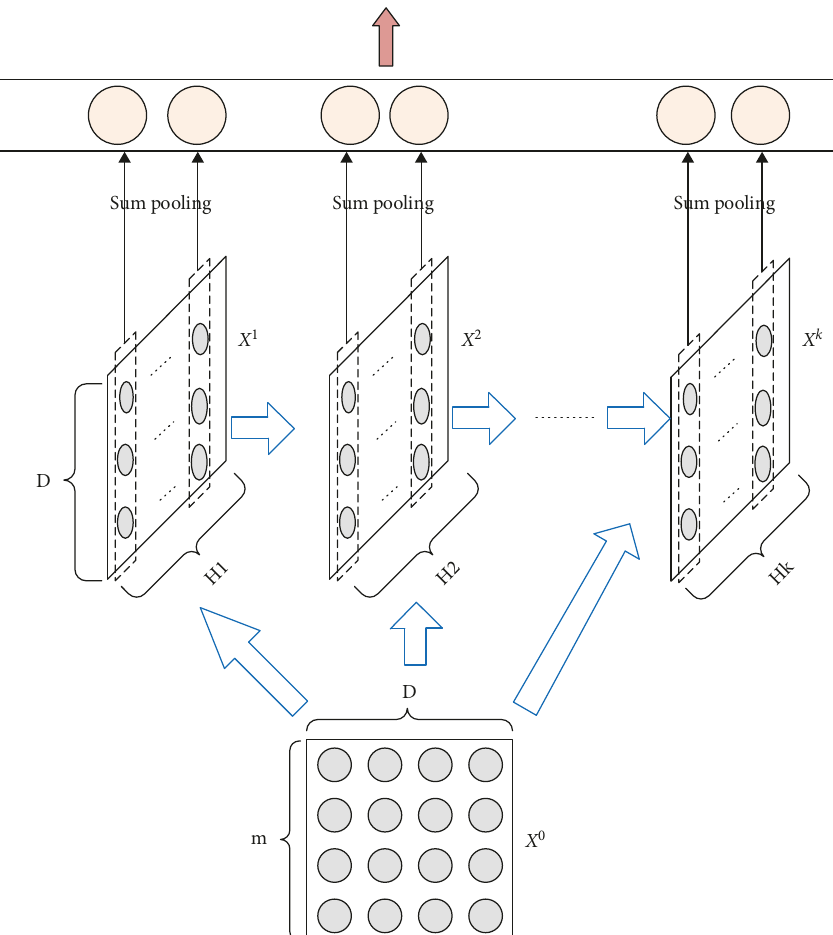
Figure 6: CIN first step calculation